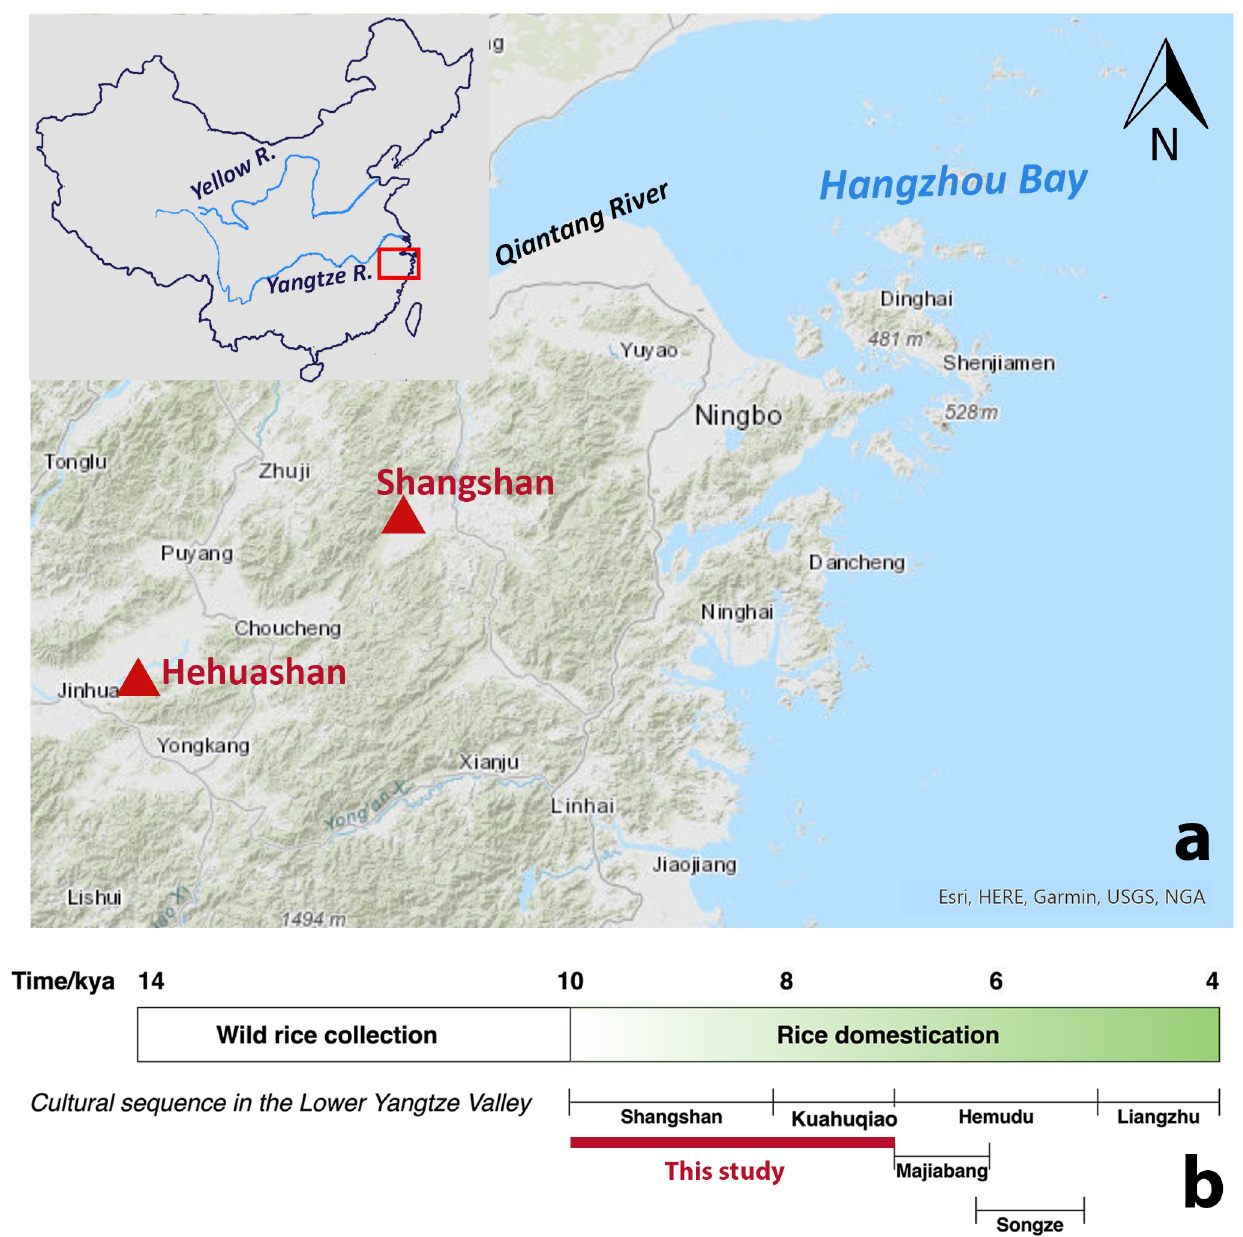
Fig 1. Archaeological background. (a) Location of Shangshan and Hehuashan, base map modified from USGS National Map Viewer (http://viewer. nationalmap.gov/viewer/); (b) Cultural history and rice domestication process in the Lower Yangtze River